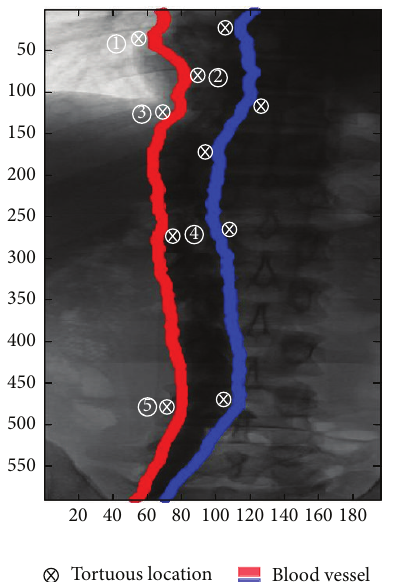
Figure 3: X-ray image, the frontal view of human body in 𝑥 - 𝑦 plane, vessel trajectories as red color and blue